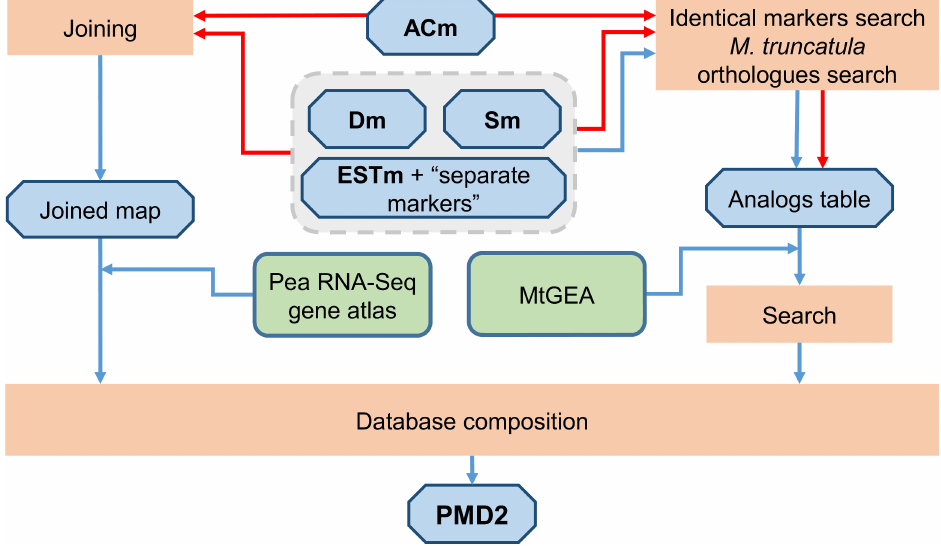
Fig 2. Pipeline of the PMD2 development. Initial and resultingdatasets are placedin blue octagons. Operations are placedin peach-colored rectangles. Steps performed previously by Tayeh and colleagues in 2015 and describedin [27] are indicatedby red arrows. Steps performed in the course of the present study are indicatedby blue arrows. MtGEA– Medicagotruncatula Gene Expression Atlas.